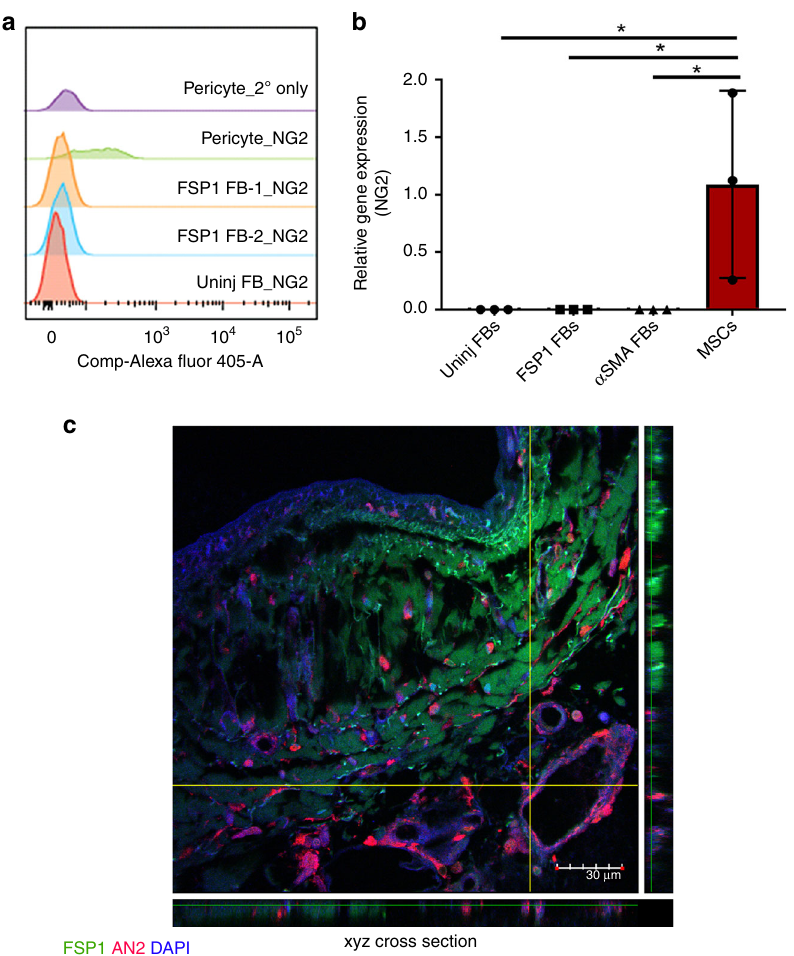
Fig. 3 FSP1 + fi broblasts do not express pericyte marker, AN2/NG2. a Staggered FACS histogram representing AN2/NG2 expression in FSP1 + and uninjured fi broblasts (P3 – P5). Human retinal pericytes were used as positive control and secondary only antibody was used as a negative control. b Relative expression of An2/Ng2 in cultured uninjured, FSP1 + , and α SMA + fi broblasts (P3 – P5). p < 0.05 was calculated by one-way ANOVA, n = 3 experiments were performed independently; bar represents mean ± SD. Mesenchymal stem cells (MSCs) were used as a positive control. c Confocal analysis of FSP1 (green), AN2/NG2 (red), and DAPI (blue) staining on post myocardial infarcted human heart; n = chain (COL1 α 1), periostin, and vimentin by IF analysis. On the other hand, uninjured fi broblasts expressed vimentin but lacked expression of activated fi broblast markers: FSP1, α SMA, periostin, and COL1 α 1. Ultrastructural evaluation of fi broblast subtypes showed abundance of rough endoplasmic reticulum, golgi appara- tus, and mitochondria with elongated nucleus in α SMA + , FSP1 + , as well as uninjured fi broblast subtypes as described earlier for fi broblasts and myo fi broblasts (Supplementary Fig. 8A) 22 . Primary mouse microvascular endothelial cells, used as a control, appeared quite distinct from the fi broblast subtypes with dense cytoplasm and fewer numbers of intracellular organelles. Moreover, around 95 – 97% of all three fi broblast subtypes stained positive for fi broblast marker MEF-SK4 by fl ow cytometry (Fig. 2e) 23 and expressed transcripts of fi broblast speci fi c markers Pdgfr α , Col3 , Col1 α 1 , and Fn1 as assessed by semiquantitative real-time PCR (Supplemen- the pericyte marker, AN2 (a mouse homolog of the rat NG2), determined by semiquantitative real-time PCR and fl ow analysis (Fig. 3a, b, Supplementary Figs. 4 and 5, Supplementary Tables 3 indicate any co-localization between FSP1 and AN2/NG2 (Fig. 3c).